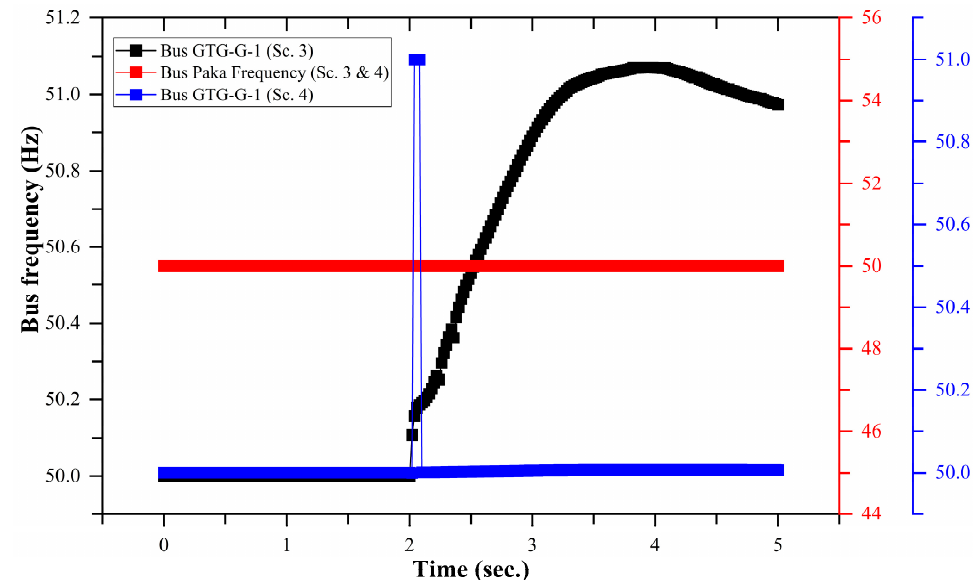
Figure 14. Bus frequency of the test system for over frequency (Scenario 3 and Scenario 4).